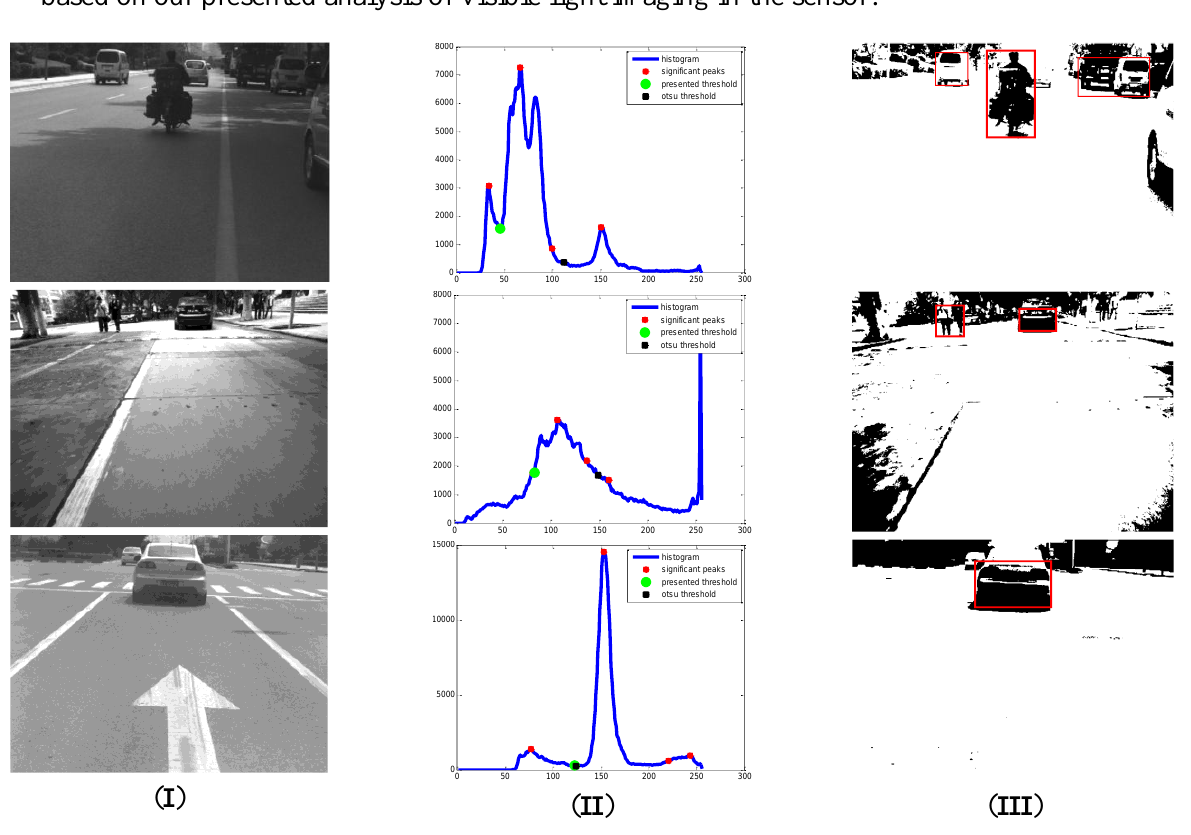
Figure 10. Some results of shadow detection of on-road obstacles based on our adaptive threshold selection method ( I ) Original on-road images ( II ) Results of threshold selection- the green circular point is selected by our proposed method, while the black rectangular point is gained by Otsu’s method. ( III ) Results of shadow detection of on-road obstacles based on our presented analysis of visible light imaging in the